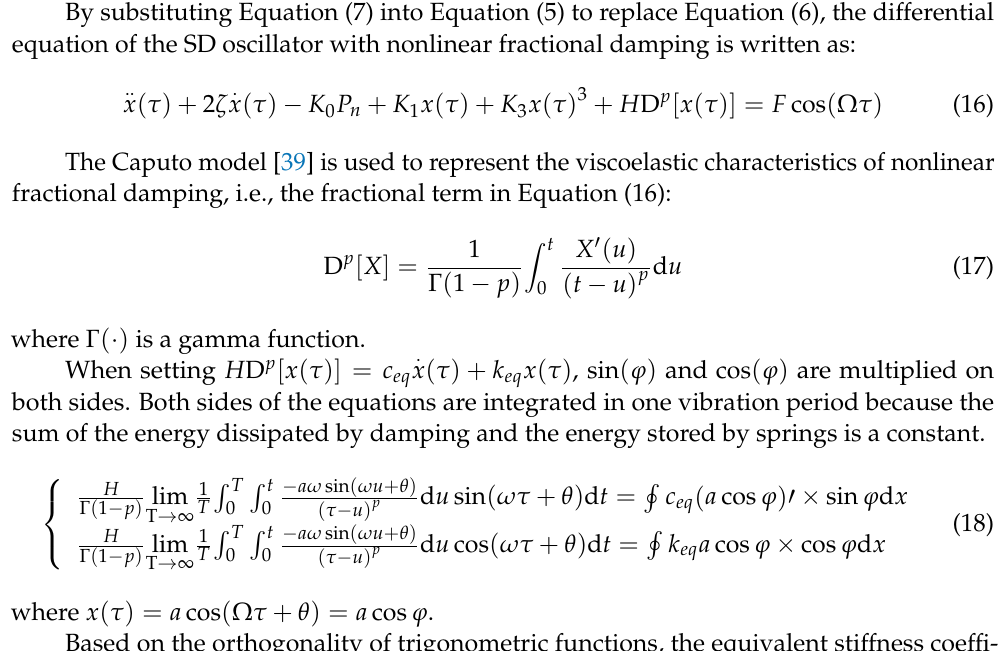
Figure 4. The results of ( a ) the equivalent stiffness coefficient k eq ; ( b ) the equivalent damping coefficient c eq